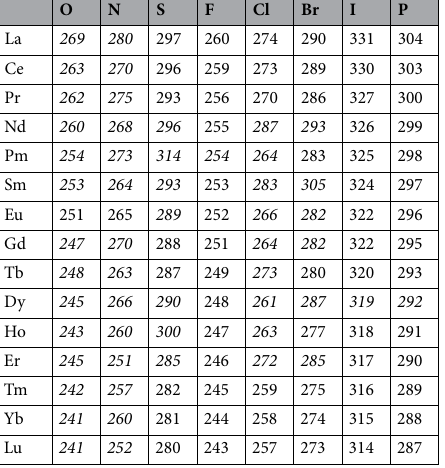
Table 2. Target coordinate bond lengths in picometers (pm) between the lanthanoid ions and the types of coordinating atoms found in our dataset. Values in italic were computed directly from the database, and the remaining values had to be interpolated from other